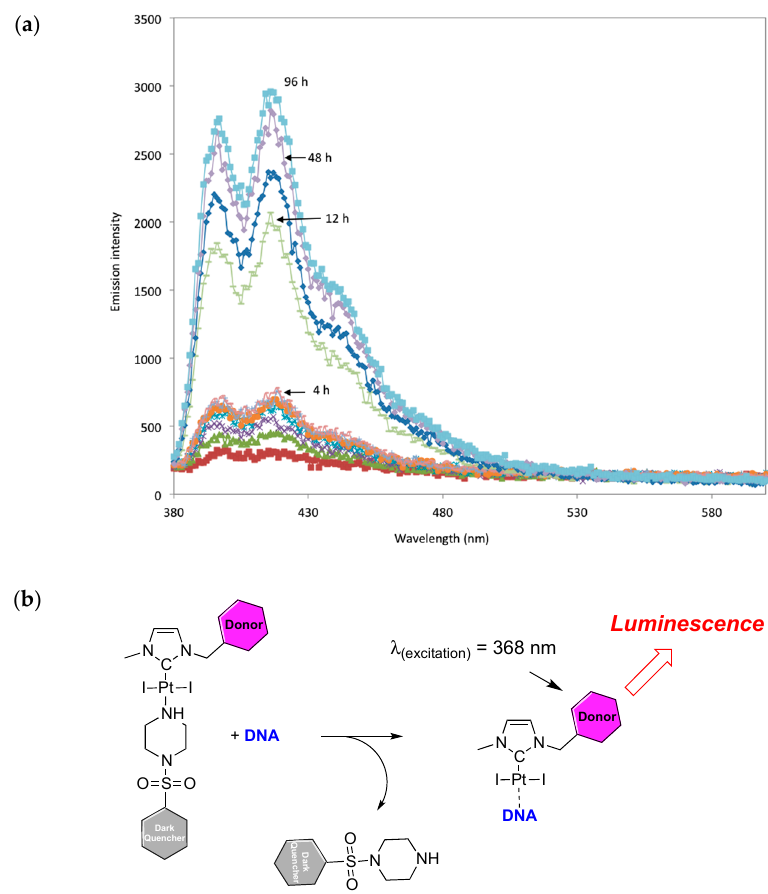
Figure 6. ( a ) Measurements of the emission spectra after excitation at λ = 368 nm (0.29 mg of 2 were dissolved in 50 µ L of DMSO and added to a solution of 1.8 mg of salmon sperm DNA in water (1.950 mL), C Pt = 1.34 × 10 − 4 , (10 base pairs compared to Pt)). ( b ) Origin or the luminescence upon interaction with DNA (50).